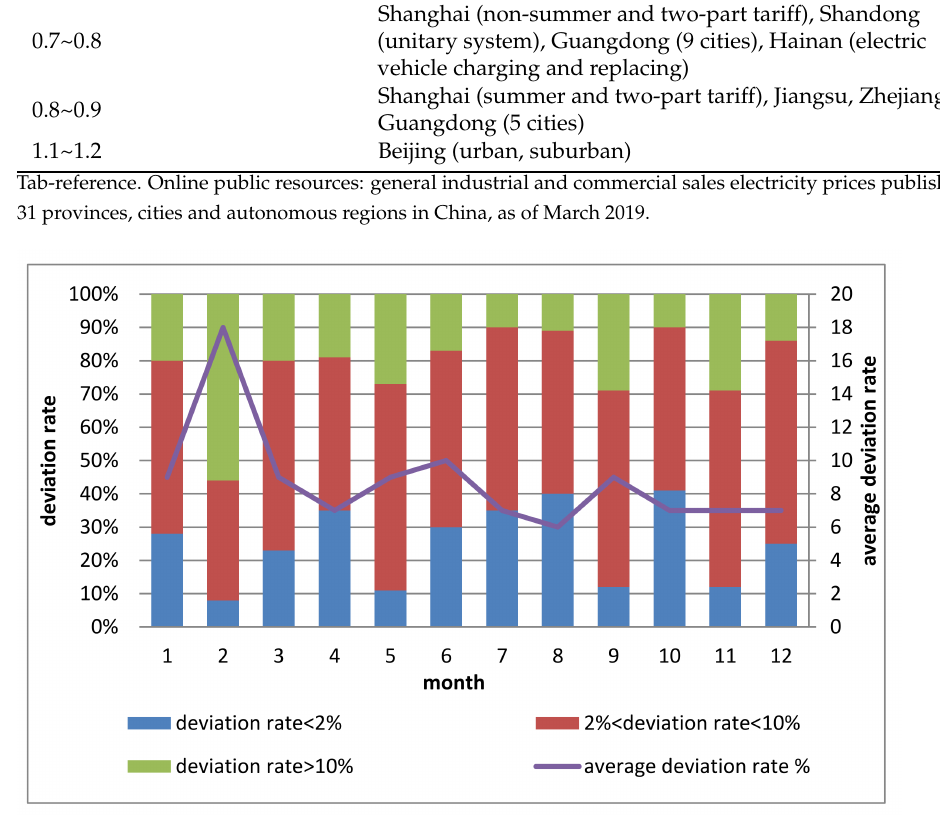
Figure 2. Electricity demand-side deviation rate of Guangdong province in 2018. Figure reference: Guangdong Electric Power Trading Center: 2018 annual report of Guangdong electric power